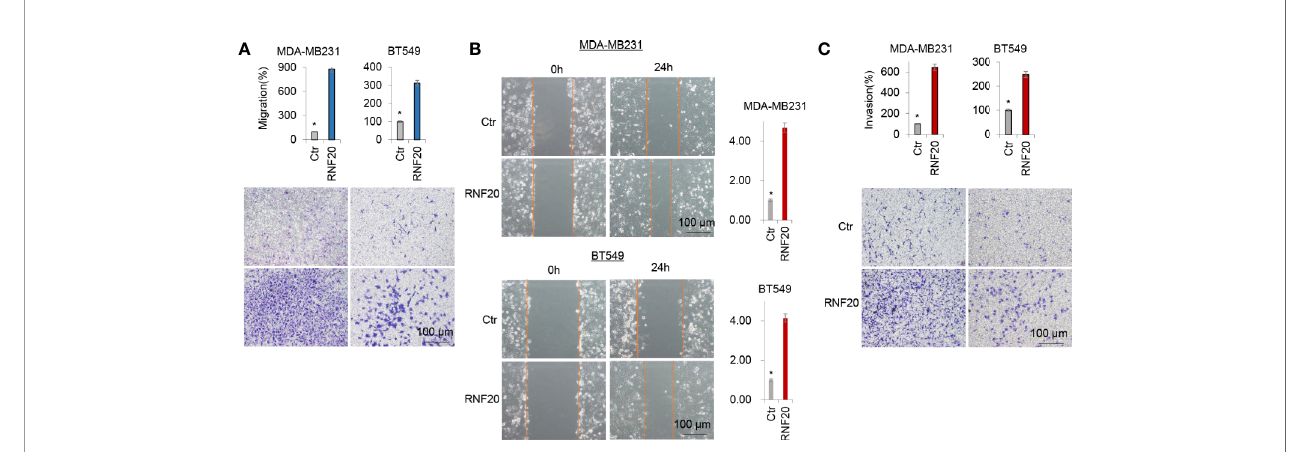
FIGURE 2 | RNF20 enhances breast cancer cell migration and invasion in vitro . (A – C) Migratory (A, B) and invasive ability (C) of MDA-MB231 and BT549 cells with stable empty vector or RNF20 expression were analyzed. The percentage of migratory and invasive cells is shown in the bar graphs (mean ± SD in three separate experiments). *P < 0.01 by Student ’ s t test: 100